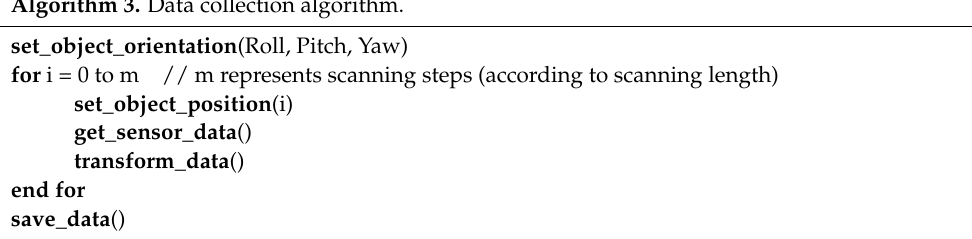
Algorithm 3. Data collection algorithm.